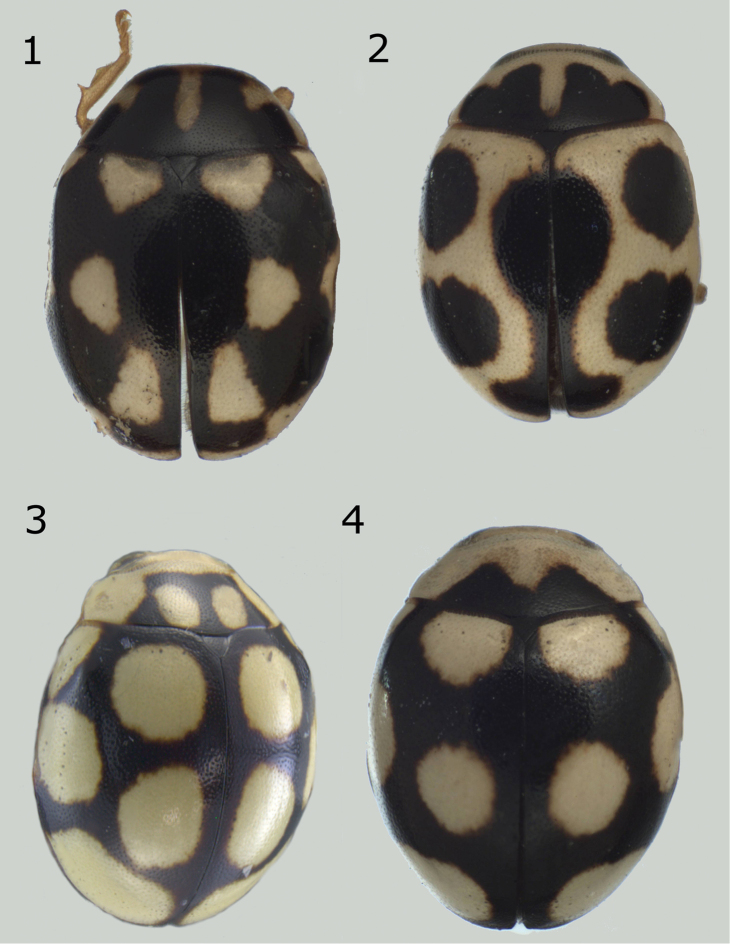
Brachiacantha sp. 1Brachiacantha
lepida, dark habitus (image by Jorge Valdez Carrazco) 2B.
lepida, common habitus (image by Jorge Valdez Carrazco) 3Brachiacantha
fenestrata, male 4Brachiacantha
octostigma, male (image by Jorge Valdez Carrazco).